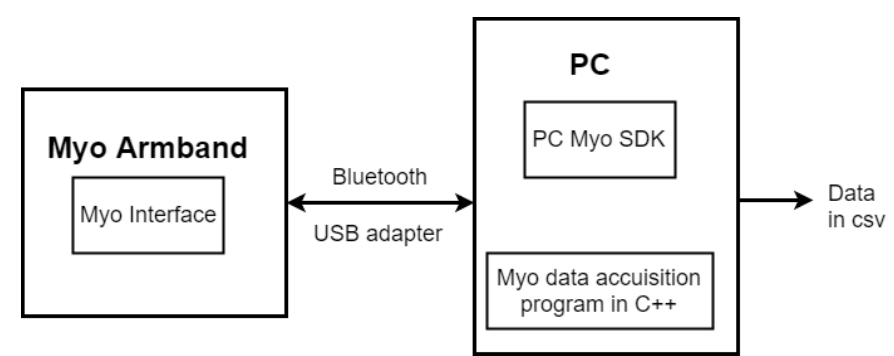
Figure 2. The Flowchart of data acquisition.